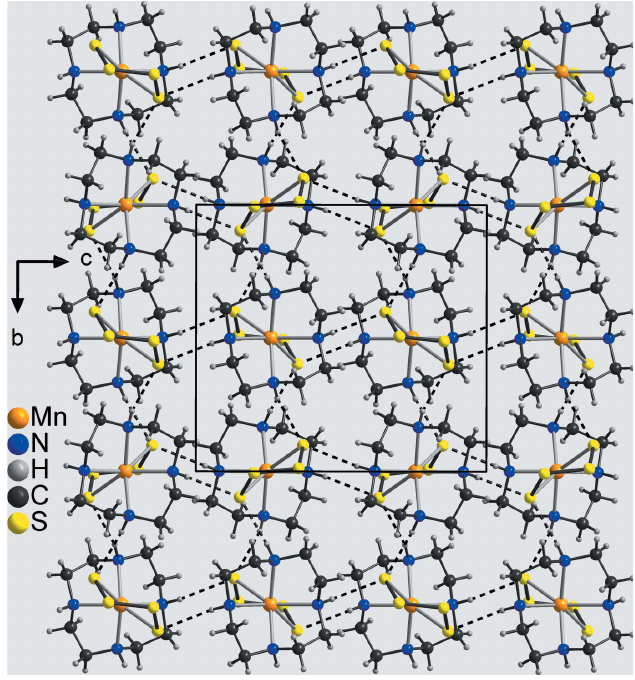
condensed into chains propagating in the b -axis direction (Fig. 4: top and Table 2). The H (cid:2) (cid:2) (cid:2) S distances of 2.50 and 2.48 A˚ and the N—H (cid:2) (cid:2) (cid:2) S angles of 148 and 152 (cid:5) indicate a relatively strong interaction (Table 2). The terminal S atoms S4 of two neighbouring complexes act as acceptors for a second hydrogen bond to the amino H atoms H4 of these complexes, also forming eight-membered rings that in this case are located on centers of inversion (Fig. 4: bottom and Table 2). These rings are condensed into chains that propagate along the c -axis direction (Fig. 4: bottom). As each complex is part of both of these two chains, layers are formed parallel to the bc plane (Fig. 5). The layers are linked into a three-dimensional network by C—H (cid:2) (cid:2) (cid:2) S and additional N—H (cid:2) (cid:2) (cid:2) S hydrogen bonding (Fig. 6 and Table 2).